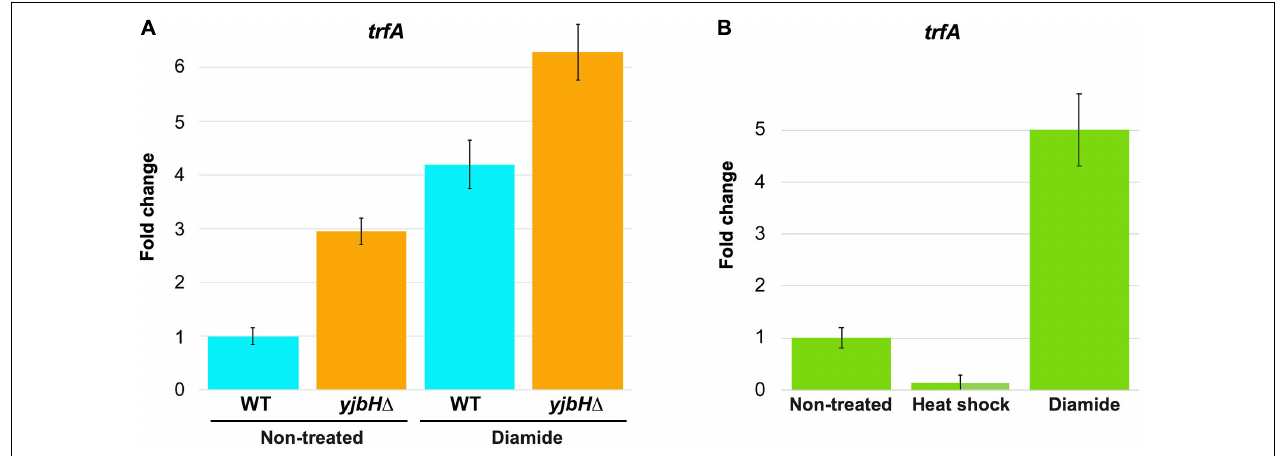
FIGURE 4 | Transcription of trfA correspond to the high protein levels and solubility of Spx. RNAs were purified from cells described in Figures 3B,C . The level of trfA RNA was measured by RTqPCR in non-treated cells and in cells treated for 30 min with either heat shock or oxidative stress induced by diamide. 16S RNA was used as a reference normalizing housekeeping gene. Fold change of trfA gene expression in treated samples relative to non-treated samples was normalized to a reference gene ( 16S RNA ). The relative gene expression in non-treated cells was set to 1. (A) The levels of trfA were increased in the yjbH deletion mutant, where the levels of Spx were increased. (B) Transcription of trfA is decreased after heat shock and increased after oxidative stress, that correspond to solubility of Spx.